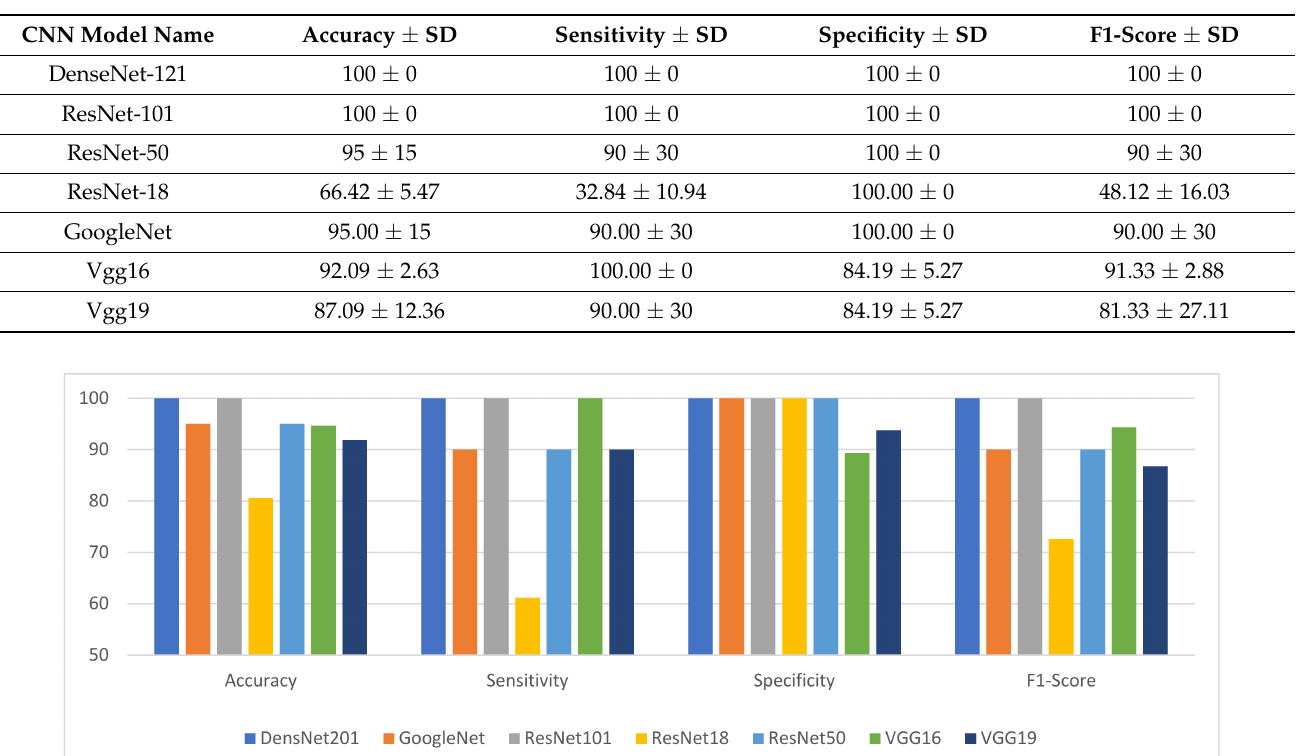
Table 5. Summary of the performance of the proposed method for K = 495 and different backbone CNN models on the INbreast dataset.